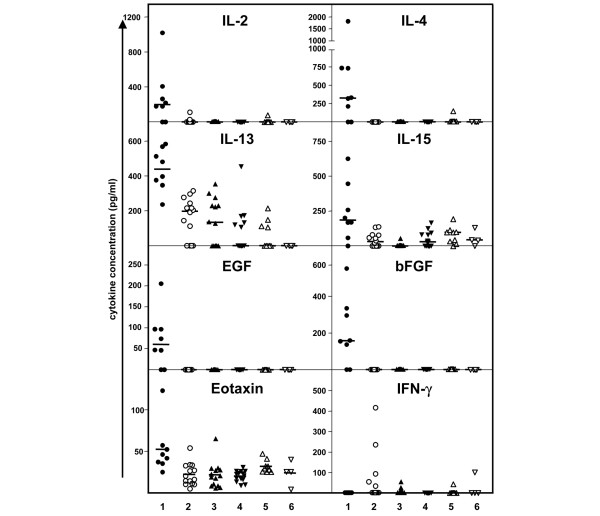
Synovial fluid cytokines in early and established arthritis. Shown are synovial fluid concentrations (pg/ml) of IL-2, IL-4, IL-13, IL-15, epidermal growth factor (EGF), basic fibroblast growth factor (bFGF), eotaxin and IFN-γ. Patient groups: 1, early synovitis that develops into rheumatoid arthritis (RA); 2, early synovitis that develops into non-rheumatoid persistent synovitis; 3, early non-crystal-related resolving synovitis; 4, crystal-related resolving synovitis; 5, established RA; and 6, osteoarthritis.